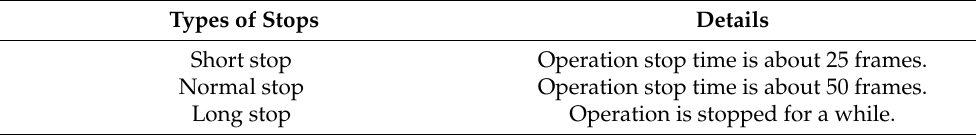
Table 1. Stops characteristics.